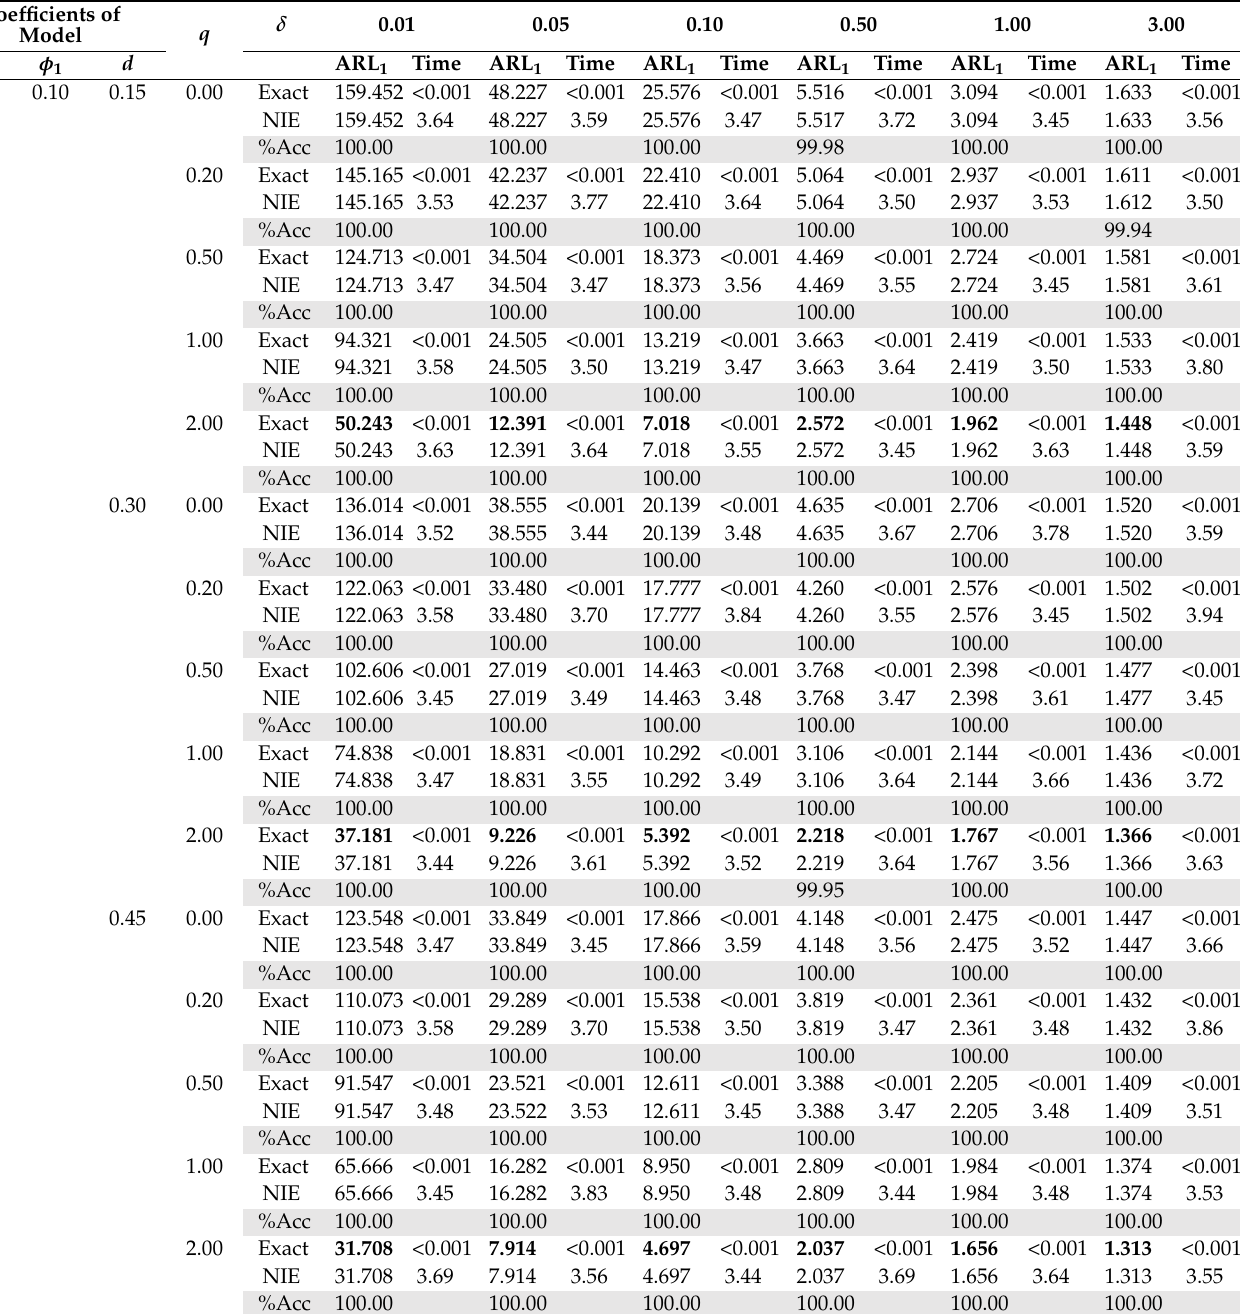
Table 2. The ARL 1 results using the exact formula and the numerical IE technique for ARFI(1, d ) processes running on the modified EWMA control chart with λ =